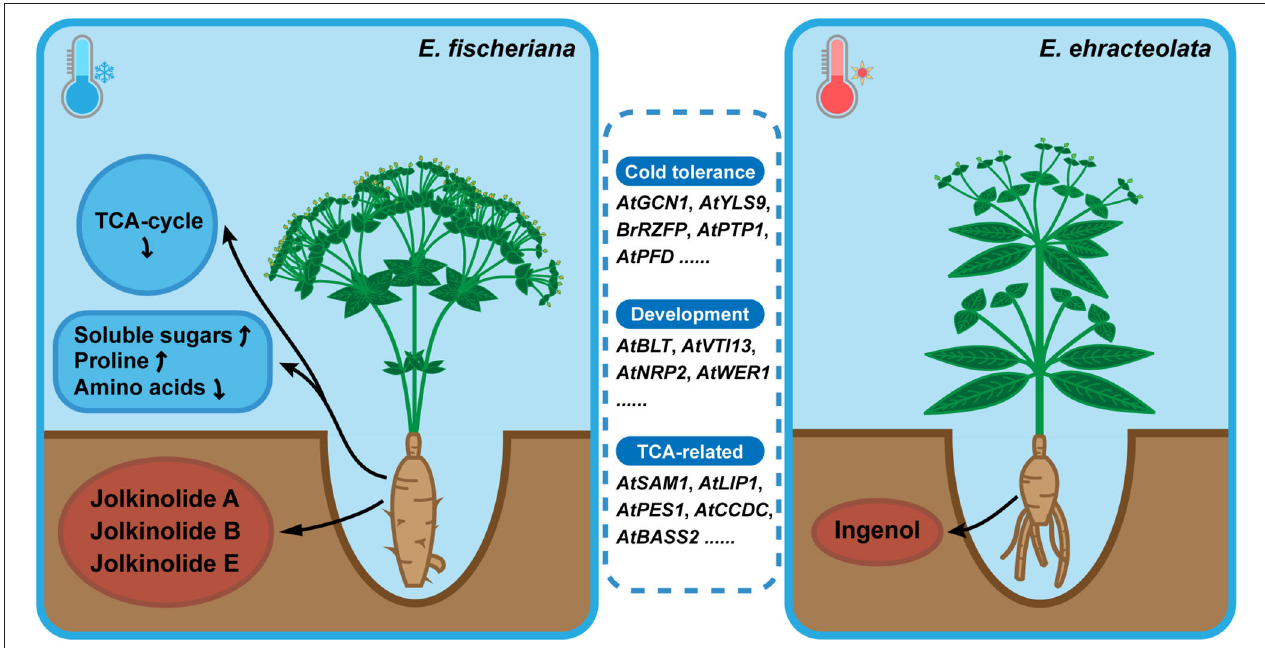
FIGURE 8 | Model for environmental adaptation mechanism of Langdu species.Compared with E. ehracteolata growing in eastern and central China, E. fischeriana growing in northern and northeast China (higher latitude) has the habitat characteristics of lower annual average temperature, presenting more tolerance of coldness than E. ehracteolata . In E. fischeriana , AtGCN1 , AtYLS9 , BrRZFP, AtPTP1 , AtPFD related to cold stress tolerance, AtBLT , AtVTI13 , AtNRP2 , AtWER1 participated in trichome, root hair and epidermal development, AtSAM1 , AtLIP1 , AtPES1 , AtCCDC , AtBASS2 related to TCA-cycle were enriched. These differences in positive selection genes may ultimately affect phenotypes and metabolites accumulation. In addition, content of soluble sugars and proline was significantly higher in E. fischeriana , whereas content of amino acids was relatively lower, compared with that in E. ehracteolata . Differential accumulation of active ingredients also existed in two Langdu species, during the evolution of environmental adaptation. E. fischeriana preferred to accumulate polycyclic diterpenes such as jolkinolide A, jolkinolide B, and jolkinolide E, whereas E. ebracteolata preferred to accumulate dicyclic diterpenes such as ingenol, reflecting different accumulation strategies of the same metabolites in related species, which is the result of long-term adaptation to the environment and also the material basis for the formation of